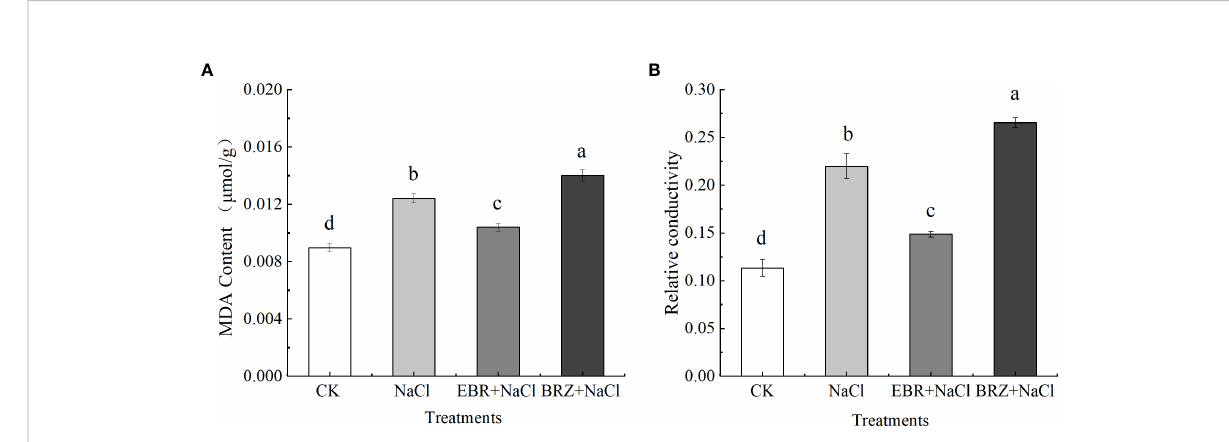
FIGURE 6 Effects of exogenous EBR on malondialdehyde (A) and relatiye conductivity (B) in leaves of cucumber seedlings under salt stress. Data are means ± SE of three replicates. Different letters indicate signi fi cant differences at P < 0.05 according to Duncan ’ s multiple range